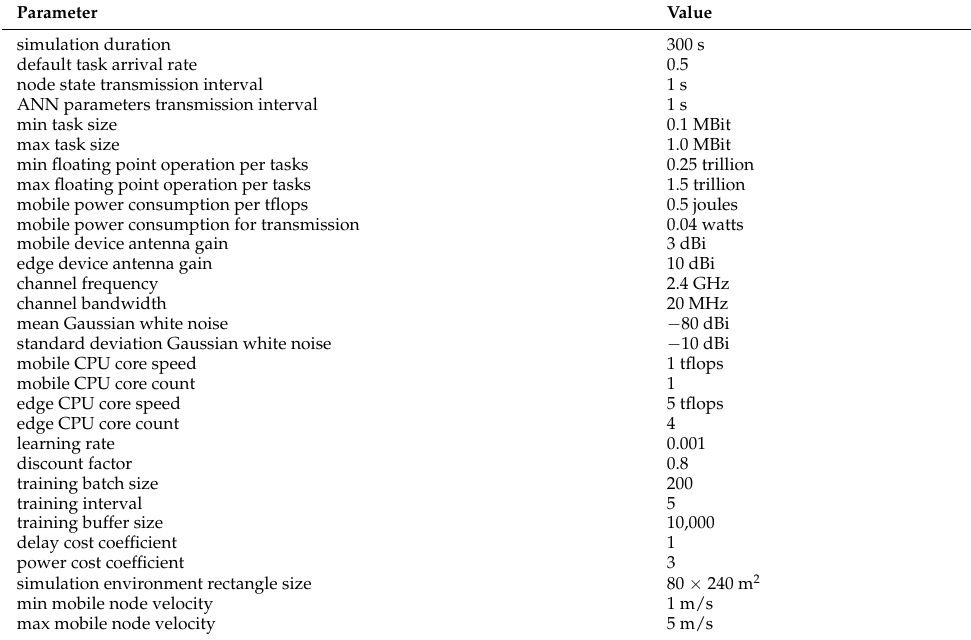
Table 1. Simulation